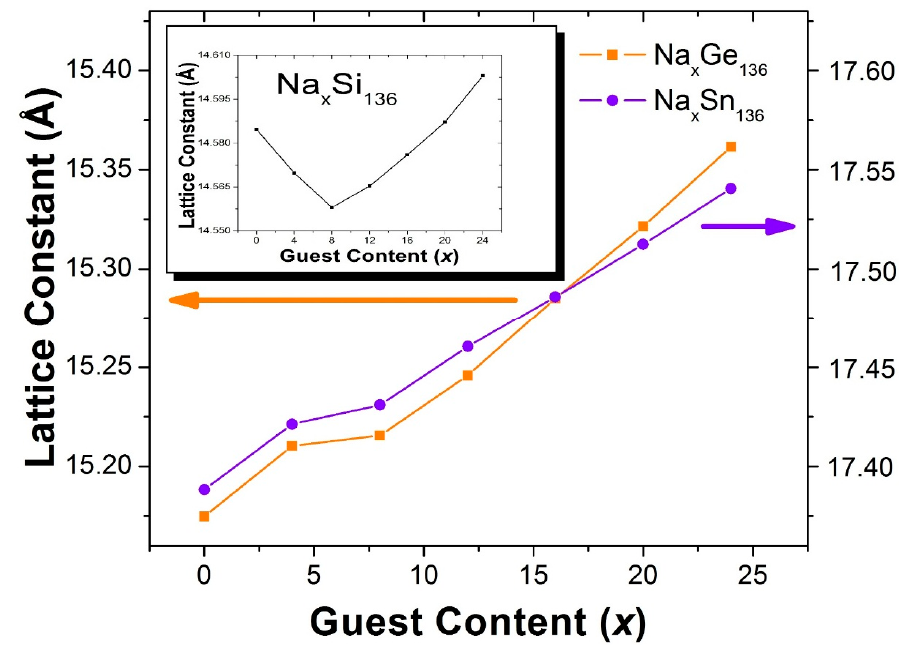
Figure 2. Predicted x Dependence of the Lattice Constants for Type II Clathrate-Based Compounds Na x M 136 (M = Si, Ge, Sn; 0 ≤ x ≤ 24).